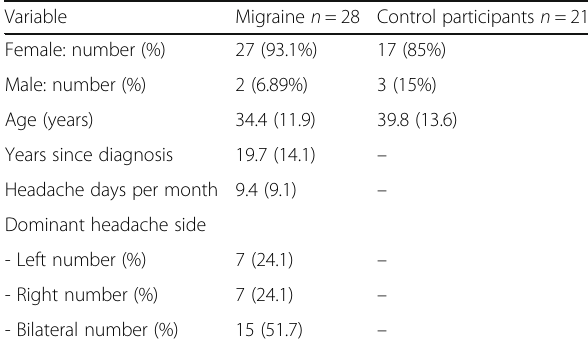
Table 2 Characteristics of groups Variable